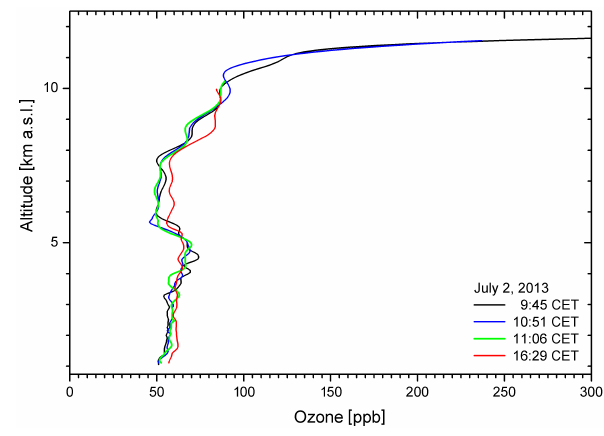
Figure 5. 313nm particle backscatter coefficients for 2 July 2013; the spikes between 11 and 12km are due to faint cirrus clouds.